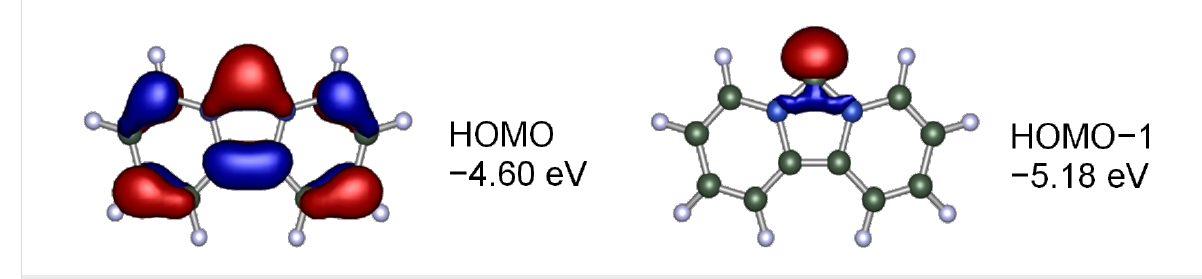
Figure 4: Highest occupied molecular orbitals for the dipyrido-annelated carbene dipiy. The σ -type carbene lone pair is not the HOMO but the HOMO − 1.